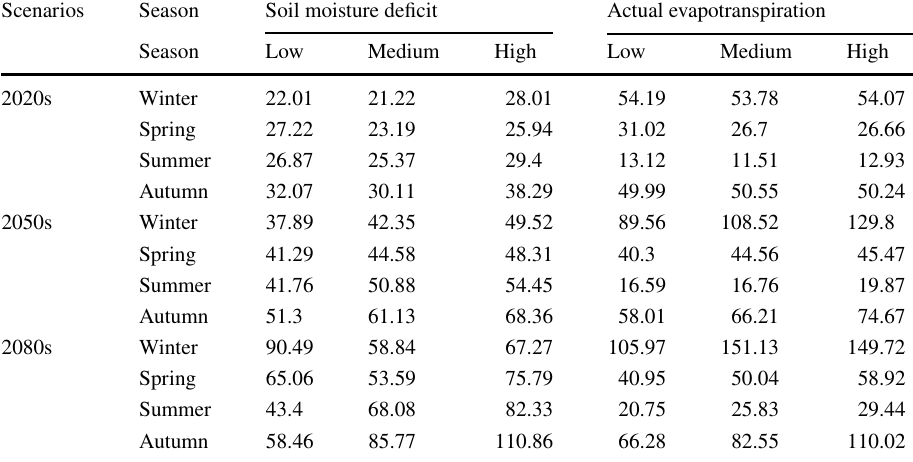
Scenarios Season Soil moisture deficit Actual